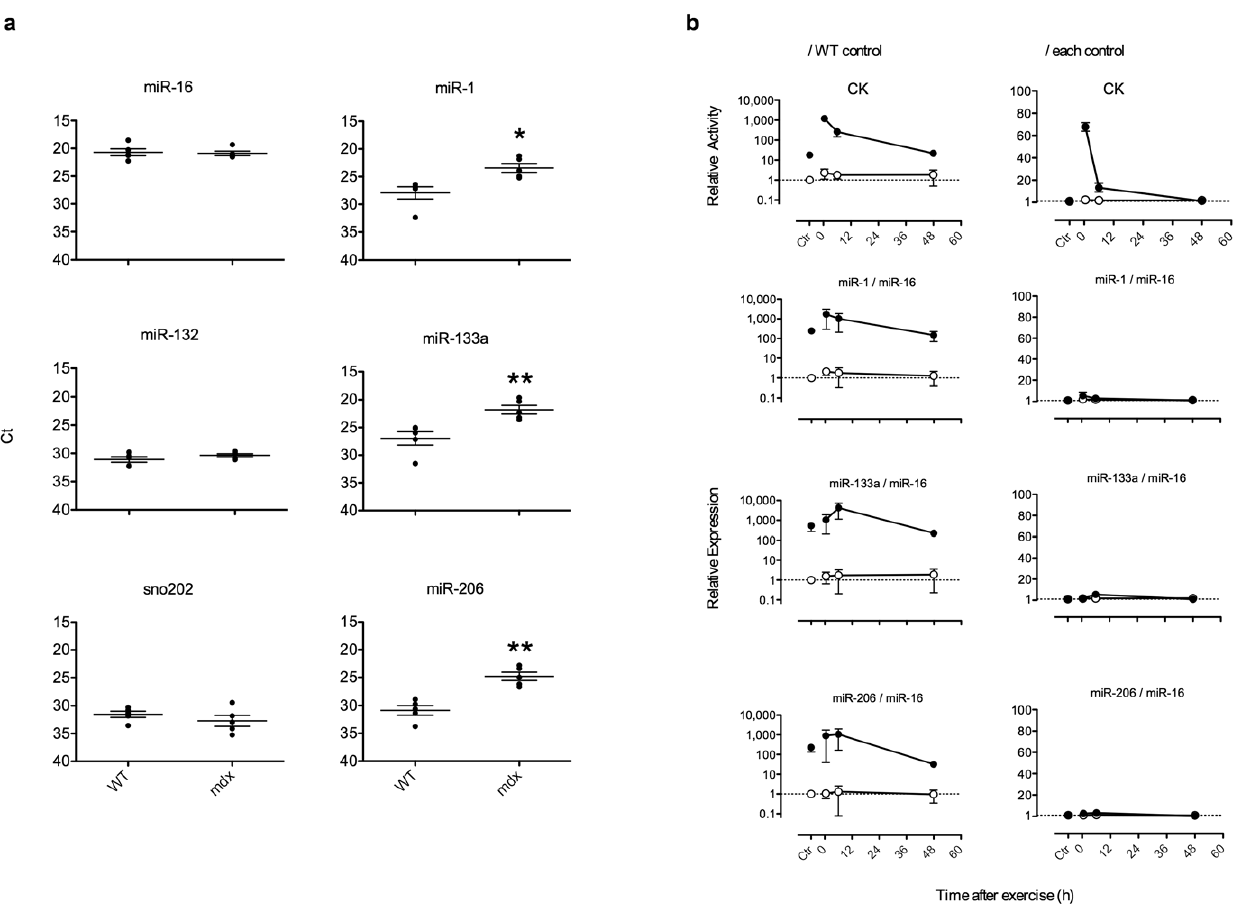
Figure 1. Elevation of muscle-specific miRNA levels in mdx mouse serum. (a) Expression levels of miRNAs in 8-week old male wild-type and mdx serum. Ct was determined by real-time PCR. In these graphs, the longer bars on each plot indicate the mean, and the shorter bars indicate 6 SEM, n=5. Asterisk (*) indicates a significant difference (*, P , 0.05; **, P , 0.01, two-tailed Student’s t-test.). The actual P value for each test was P=0.797 (miR-16), 0.222 (miR-132), 0.344 (sno202), 0.011 (miR-1), 0.007 (miR-133a) and 0.001 (miR-206). (b) CK and miRNA expression levels in wild- type and mdx serum after treadmill exercise. Running on the treadmill was continued for 20 min. About 100 m l of blood was collected from the tail vein at 0.5, 6 and 48 h after the exercise. Six days before the test, blood was collected as a control. Expression levels were normalized to the wild-type control (left) or each individual control (right). Data are presented as mean 6 SEM, n=3. # : wild-type;